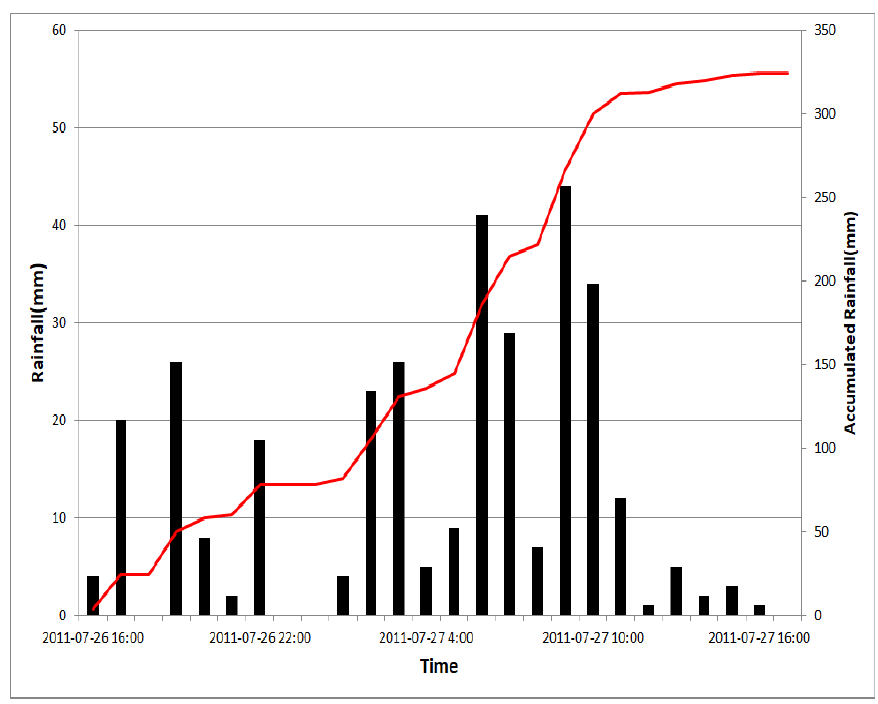
Figure 8. Hyetograph for Sadang-dong (26 July 2011, 16:00 – 27 July 2011, 16:00).